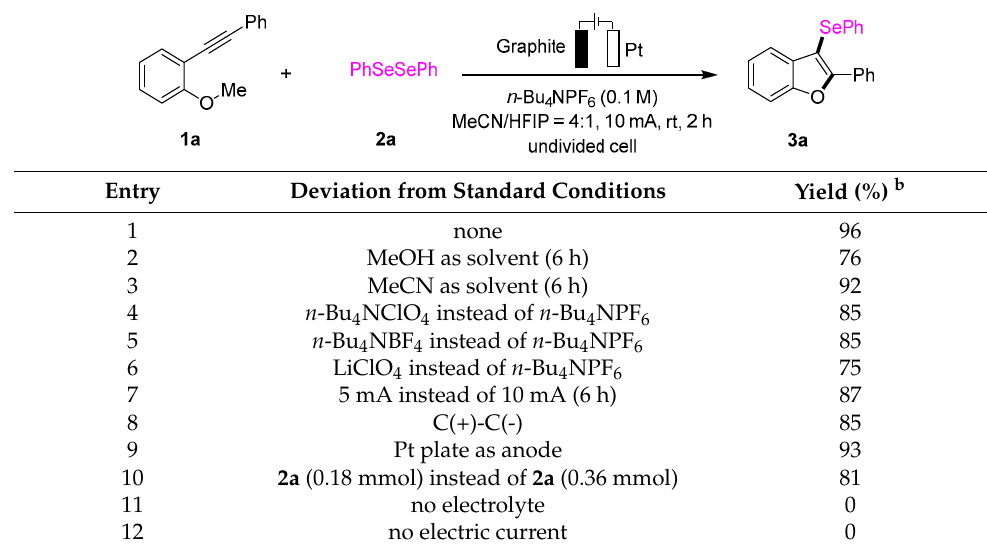
Table 1. Optimization of the Reaction Conditions a .